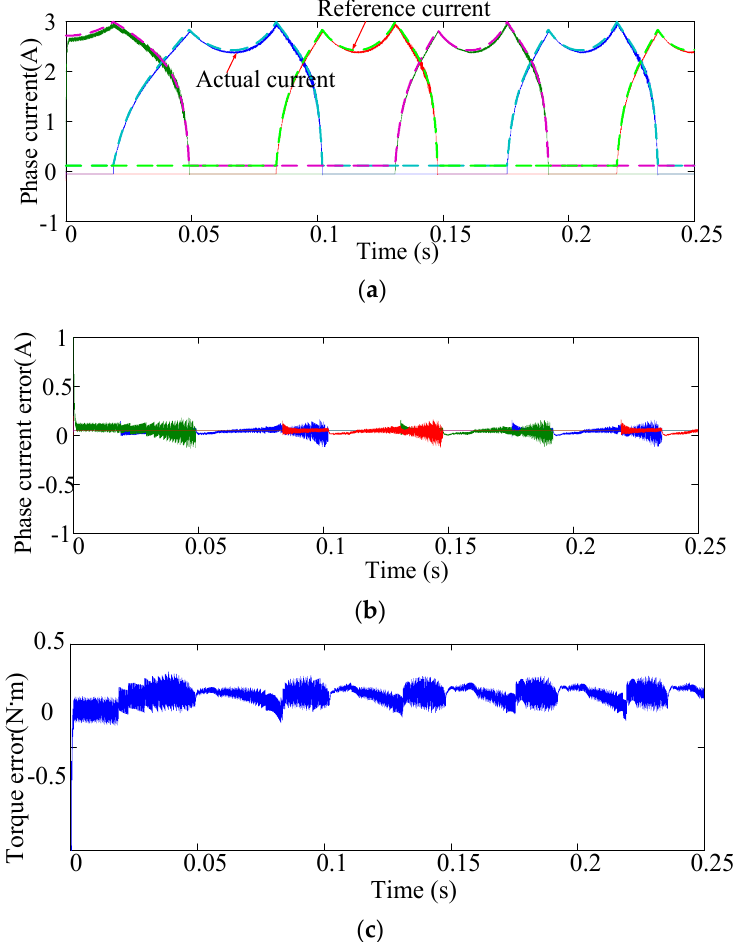
Figure 12. Simulation results when using predictive current method based on linear TSF (reference torque is set 3.7 N · m and sample time is set 1 × 10 − 5 s). ( a )Phase current error ( b ) Profiles of phase current and its reference ( c ) Torque error.